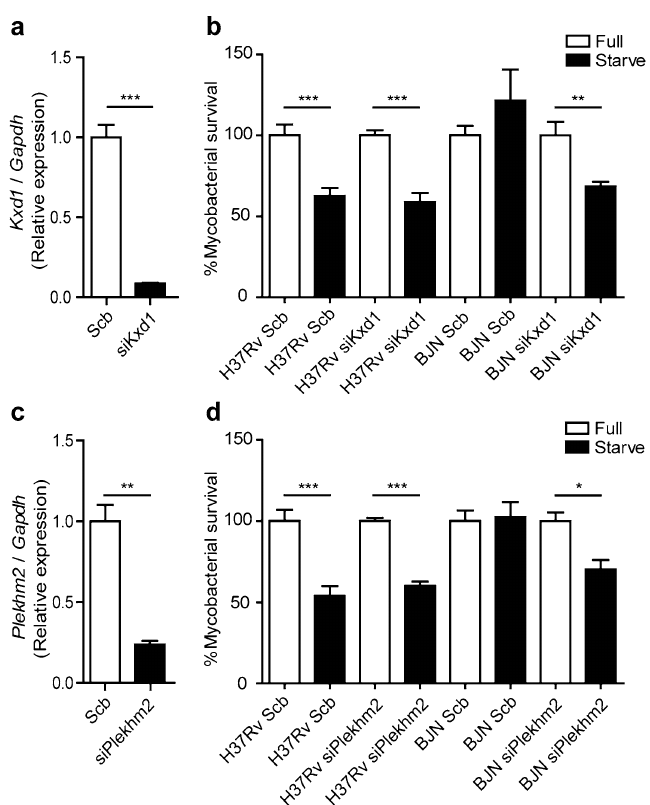
Figure 3. Kxd1 and Plekhm2 required for evasion of starvation-induced autophagic elimination by the BJN strain. ( a ) Raw264.7 cells were transfected with non-targeted scrambled control or Kxd1 -targeted siRNAs. At 48 h after transfection, Kxd1 expression levels were determined by qRT-PCR. Data are means ± SEM from at least three independent experiments; ***p < 0.001 was determined by two-tailed unpaired Student’s t-test. ( b ) Kxd1-deficient macrophages were infected with the M. tuberculosis reference strain H37Rv or BJN for 1 h and then subjected to autophagy induction by starvation for 4 h. Cells were lysed by osmotic burst to harvest intracellular mycobacteria. Percent mycobacterial survival was determined by plating for CFU. Data are means ± SEM from at least three independent experiments; **p < 0.01 and ***p < 0.001, all relative to the full control set of 100% were determined by one-way ANOVA with Tukey’s multiple comparison test. ( c ) Plekhm2 expression was depleted using the siRNA-mediated knockdown and expression levels were determined by qRT- PCR as in ( a ). Data are means ± SEM from at least three independent experiments; **p < 0.01 was determined by two-tailed unpaired Student’s t-test. ( d ) Plekhm2-depleted macrophages were infected with different mycobacteria and subjected to autophagy induction by starvation as in ( b ). Mycobacteria intracellular viability was then determined by plating for CFU. Data are means ± SEM from at least three independent experiments; *p < 0.05 and ***p < 0.001, all relative to the full control set of 100% were determined by one-way ANOVA with Tukey’s multiple comparison